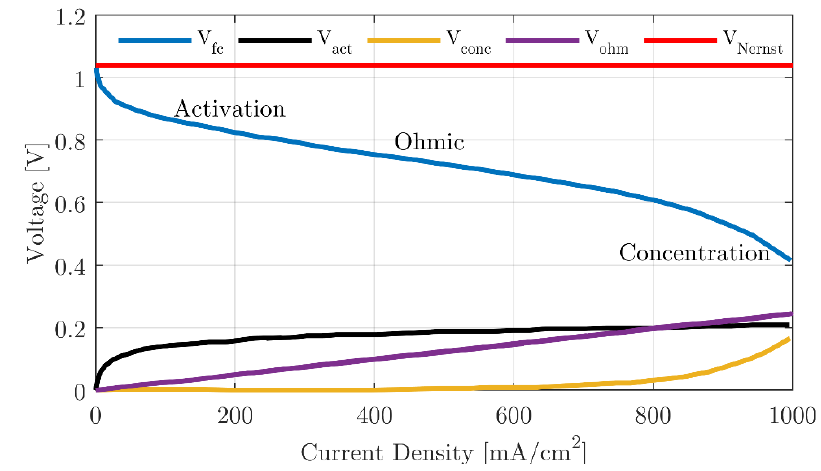
Figure 5. Polarization curve of the PEMFC. Table 1. Avista 500-W Fuel Cell stack parameters.